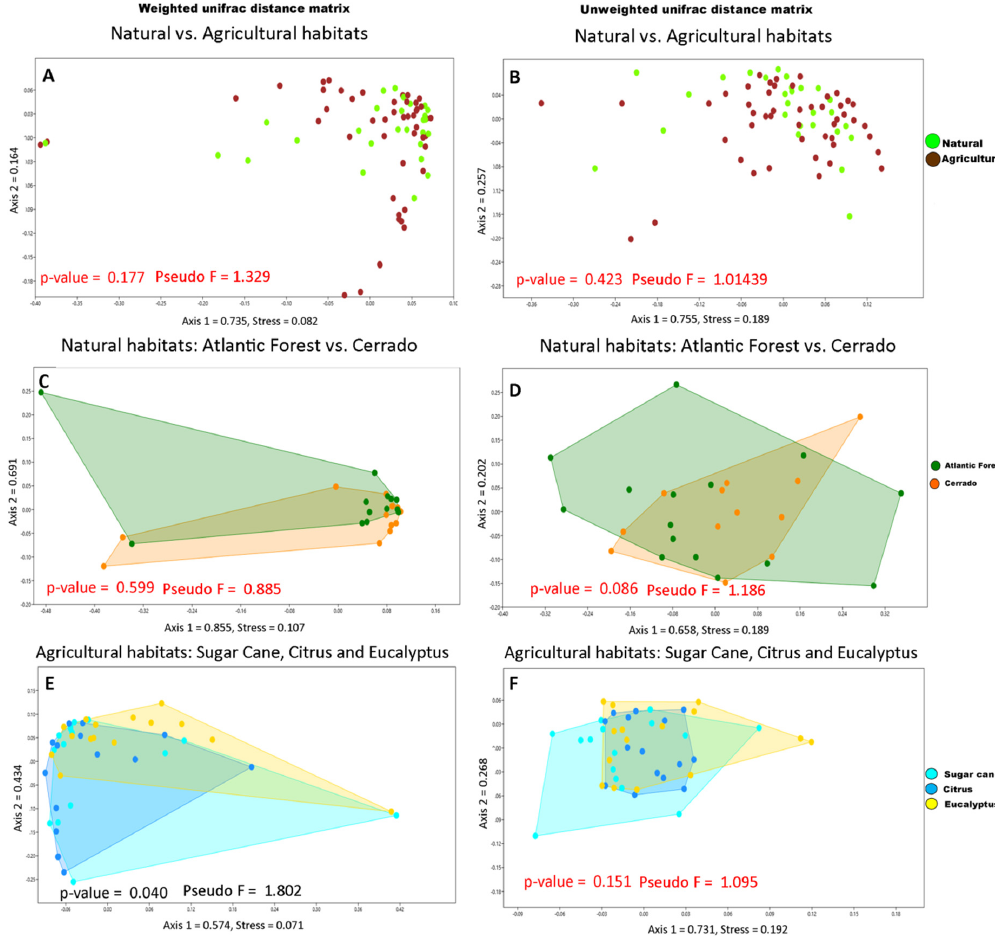
Figure 3. Non-metric multidimensional scaling (NMDS) plot illustrating bacterial community structure among Atta sexdens workers of natural vs. agricultural habitats. ( A ). Weighted unifrac distance matrix for samples from natural and agricultural habitats. ( B ). Unweighted unifrac distance matrix for samples from natural and agricultural habitats. ( C ) . Weighted unifrac distance matrix for samples from Atlantic forest and Cerrado. ( D ) . Unweighted unifrac distance matrix for samples from Atlantic Forest and Cerrado. ( E ) . Weighted unifrac distance matrix for samples from agricultural habitats. (F ) . Unweighted unifrac distance matrix for samples from agricultural habitats. Dots were colored according to the di ff erent groups. The distance between bacterial communities represents their underlying distance in the multivariate space. Statistics highlighted in red show p values greater than 0.05. Besides one significant p value in the weighted unifrac distance for the agricultural habitat, note that there is not a clear structuring of the different groupings.